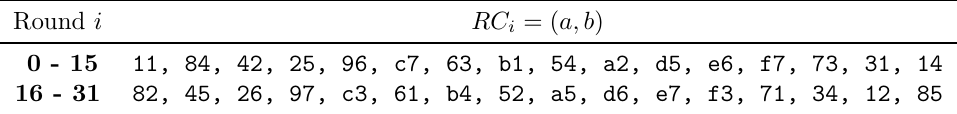
Table 2: Round constants of